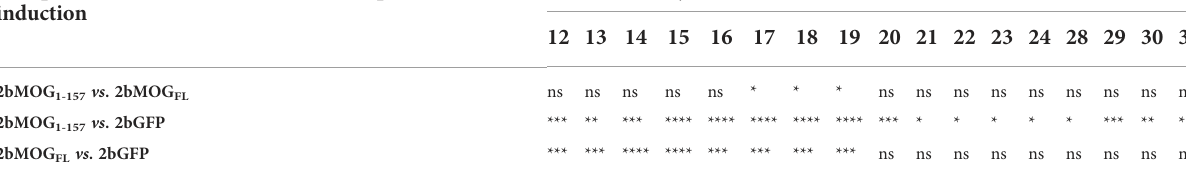
‡ . Days after EAE induction ‡ (Individual P-value)